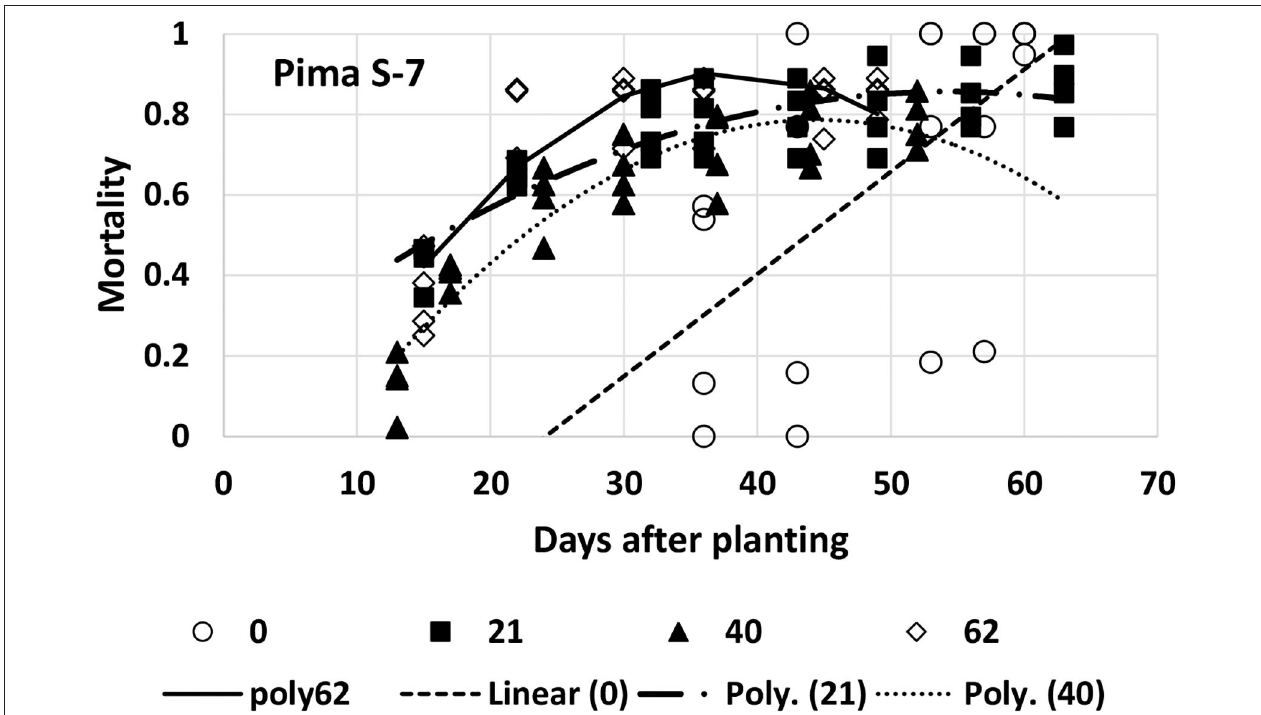
FIGURE 8 | Proportion of plants that emerged and then died (mortality) over time for Pima S-7 at planting times of day 0, 21, 40, and 62 (day 0 occurred on 16 April). A linear model was fitted to day 0 [Linear (0)] and quadratic models for the last three planting dates (Poly 21, 40, 62).